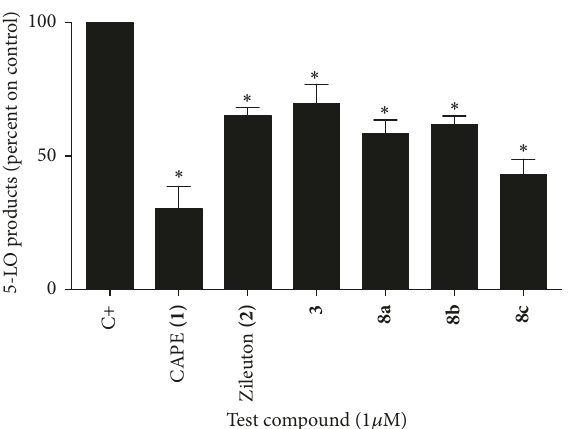
Figure 5: Inhibition of 5-LO products synthesis by 12a–c and 8b in whole HEK293 cells. Values are the means ± SEM of three independent experiments, each performed in quadruplicate; ∗ differentfromcontrol(diluent)asdeterminedbyone-wayANOVA with Dunnett’s multiple comparison test ( 𝑝 < 0.05